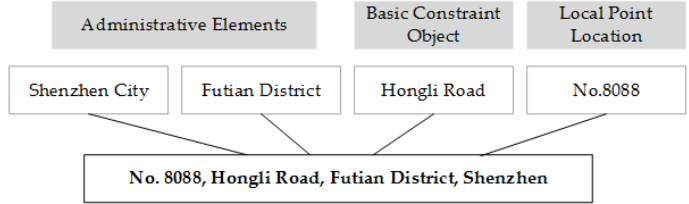
Figure 3. An example of the organization rules for addresses.